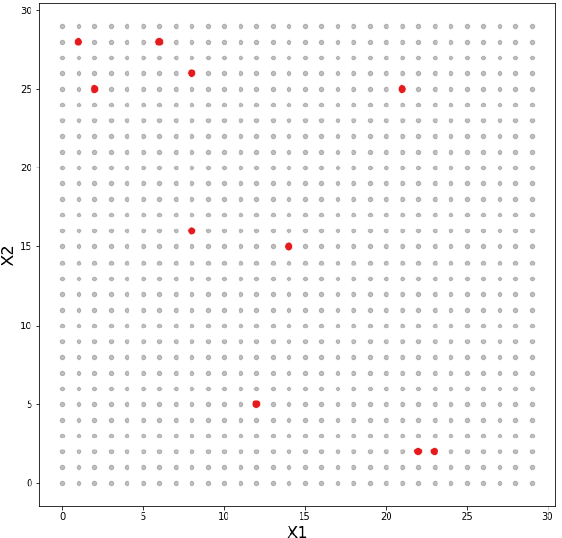
Figure 5. An example of how IoT points and devices are plotted within the desired area by generating an x , y coordinate matrix.